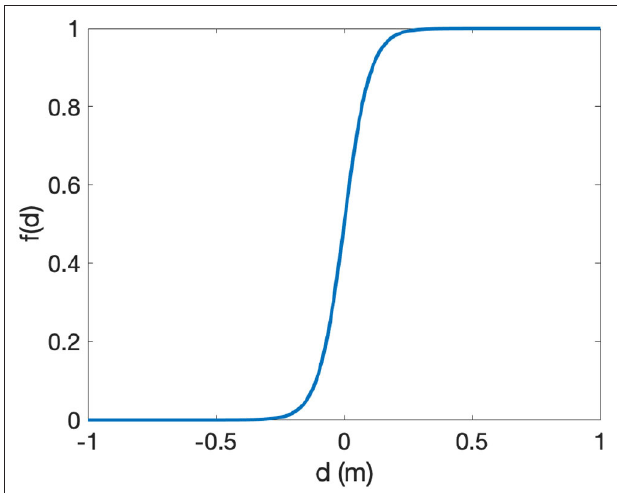
FIGURE 3 | Switching function f ( d ) (Equation 3). Parameter values are in Table 2